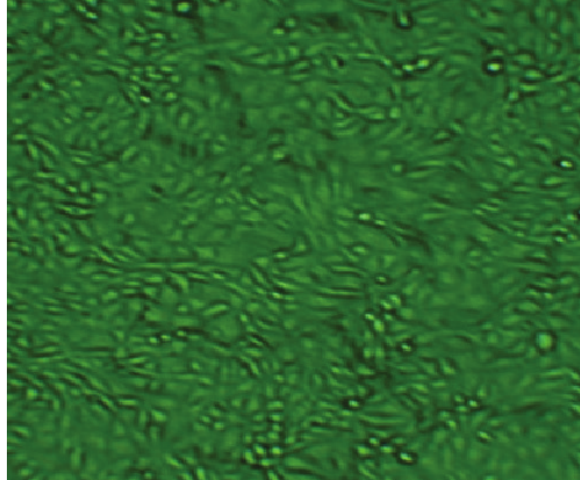
Figura 6. Monocamadas de células MDBK em cultura com TCM199 acrescentado em 10% de soro bovino fetal (100x, 4x